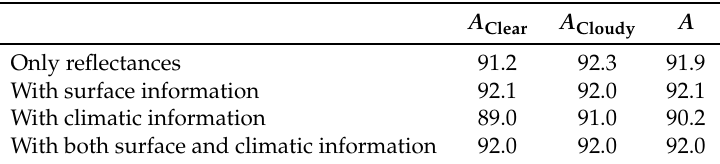
Table 11. Accuracy of ANN when ancillary information is introduced as a fifth variable. Global accuracy is shown for the entire dataset ( A ) and separately for Clear ( A Clear ) and Cloudy ( A Cloudy ) scenes when no ancillary information are used, and surface type, climate and both are used. A Clear A Cloudy A Only reflectances 91.2 92.3 91.9 With surface information 92.1 92.0 92.1 With climatic information 89.0 91.0 90.2 With both surface and climatic information 92.0 92.0 92.0